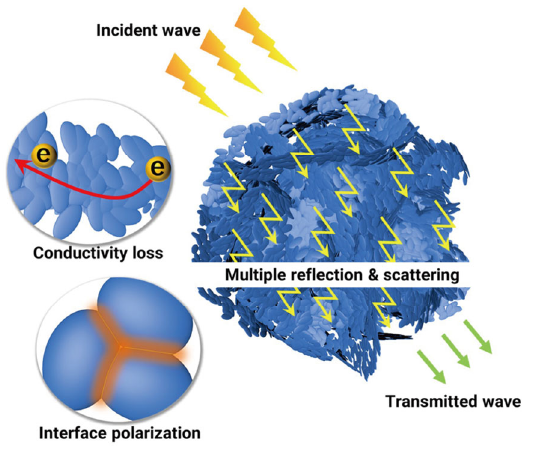
Fig. 8 Schematics of microwave absorption mechanisms of the CoSe 2 microclew